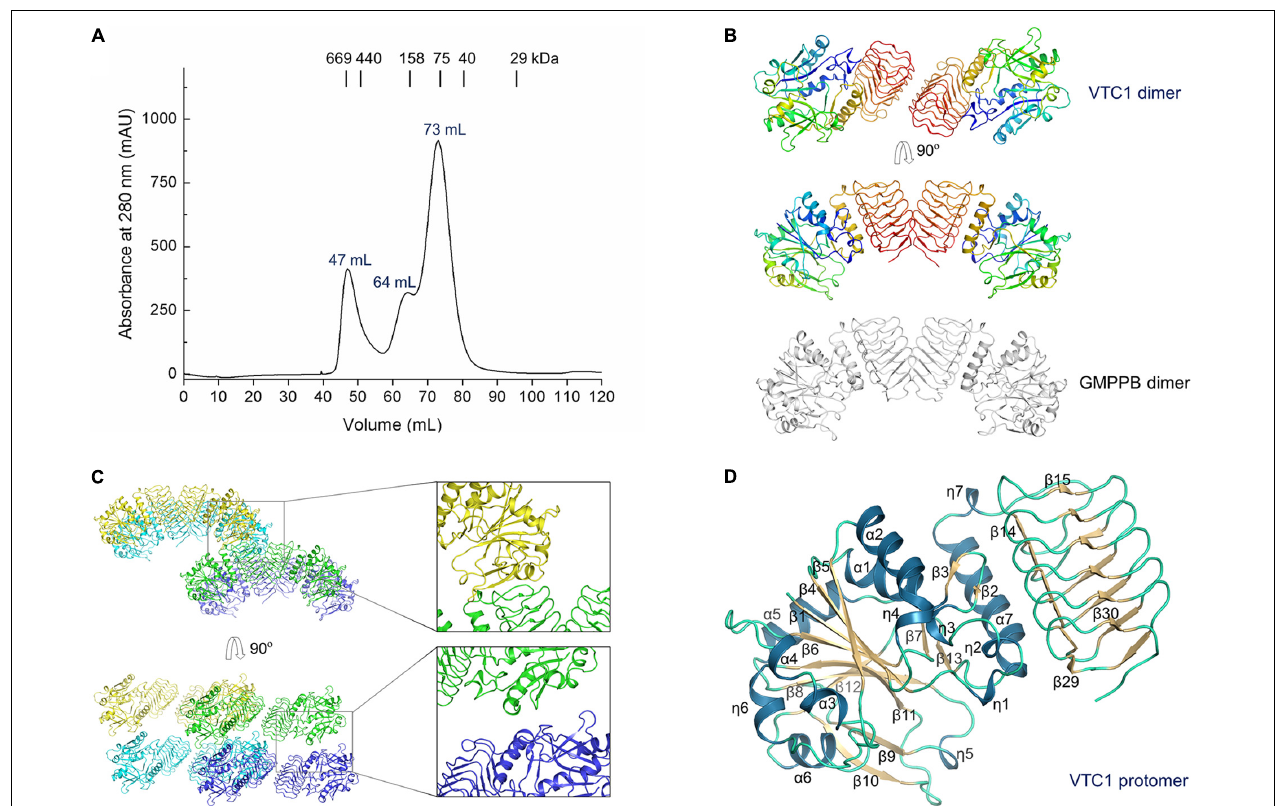
FIGURE 2 | Purification of VTC1 and the unliganded structure. (A) SEC profile on a HiLoad 16/60 Superdex 200 column (GE Healthcare). The peak volumes of the VTC1 aggregate, tetramer, and dimer are labeled; the peak positions of the protein standards are indicated with corresponding molecular weights. (B) Ribbon representation of VTC1 dimer and GMPPB dimer (gray). Each VTC1 protomer is colored in rainbow with N-terminus in blue and C-terminus in red. (C) Crystal packing of VTC1. Four neighboring dimers are shown in green, blue, cyan, and yellow, respectively. The insets are enlarged view of the inter-dimer interfaces. (D) Ribbon representation of a VTC1 protomer. The secondary structures are colored as: dark blue, dark yellow and pale green for α -/ η -helices, β -strands and loops. For clarity, only the first two and last two β -strands in the L β H domain are labeled.